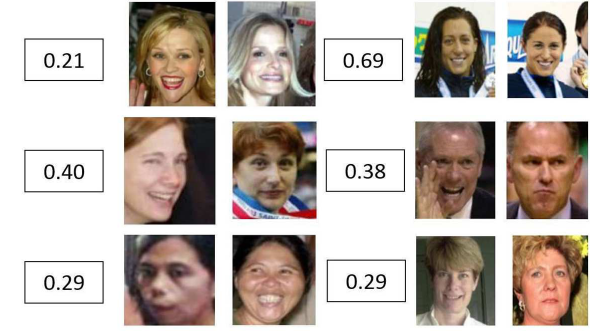
Figure 18. The face pairs in LFW were identified with great difficulty by other methods but could be distinguished between easily by our method.